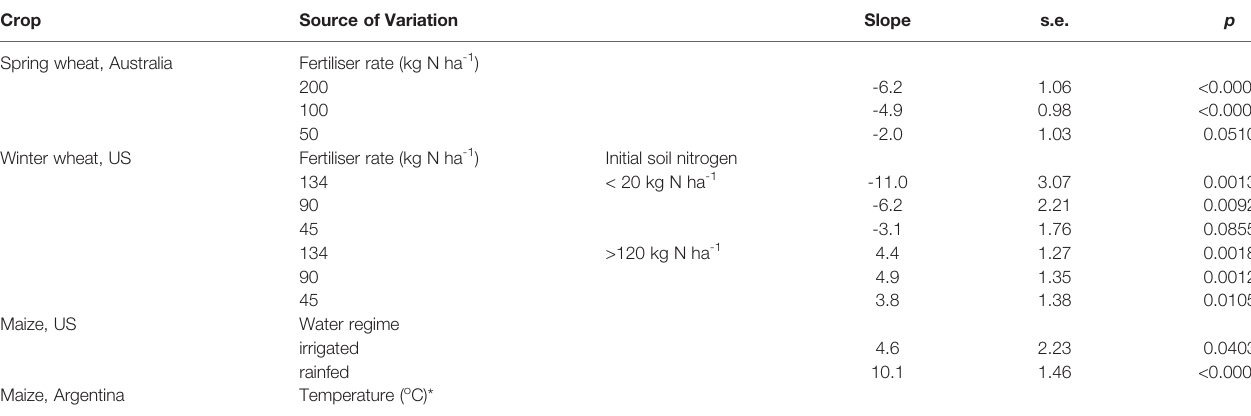
( Supplementary Figure 3 ) precludes the assessment of temperature and daylength effect; thus, the analysis in the next section only considers temperature.